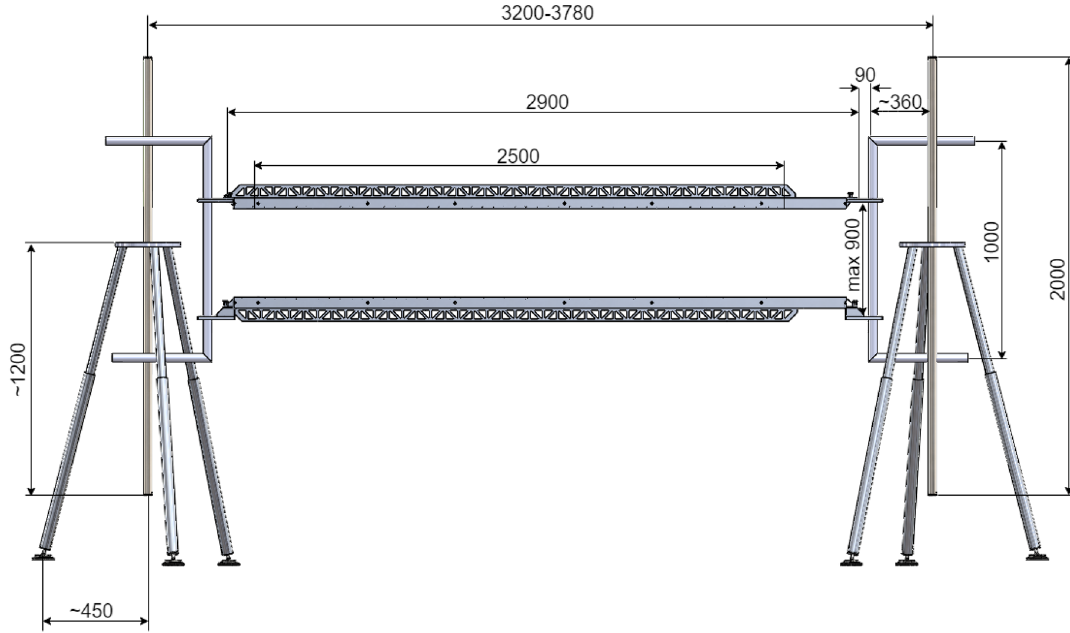
Figure 3. Diagram of the designed